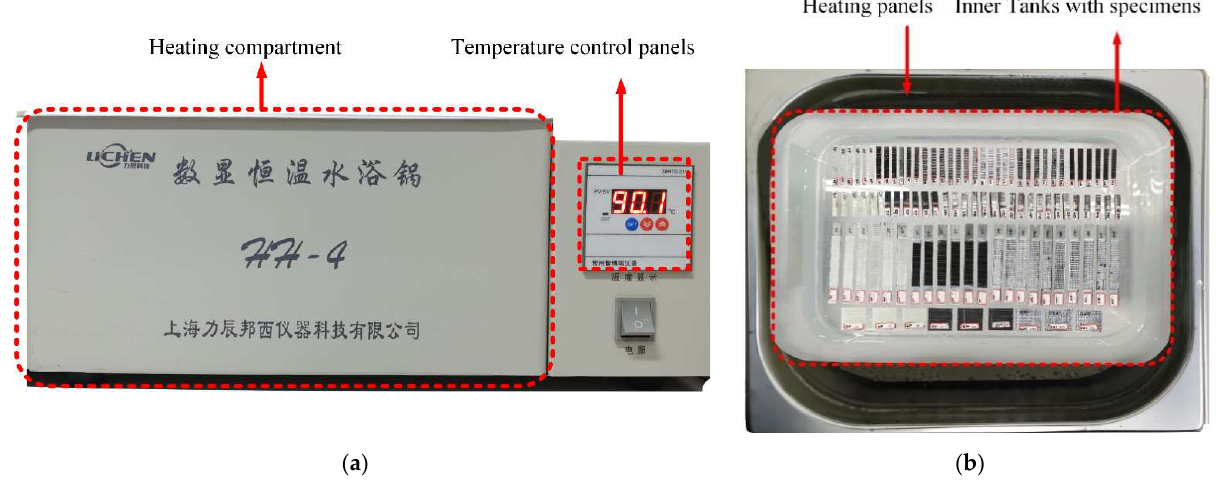
Figure 2. Photograph of ageing chamber ( a ) outside ( b ) Inside.